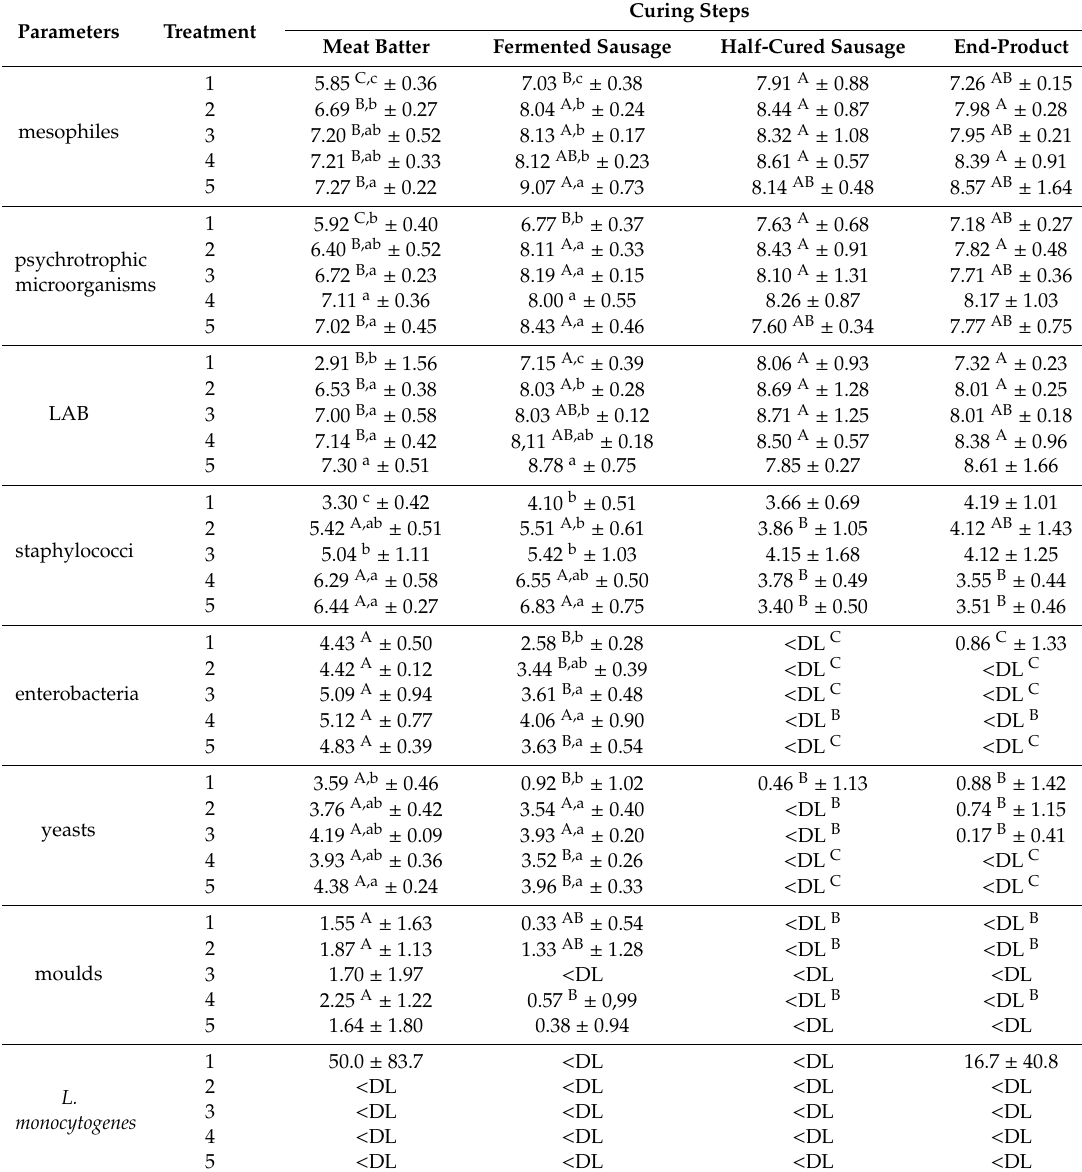
Data are expressed as means ± SD. < DL: below the detection limit of the corresponding analytical method (10 cfu / g). Results are expressed in log cfu / g. Results for L. monocytogenes are reported as cfu / g. 1—control; 2— S.